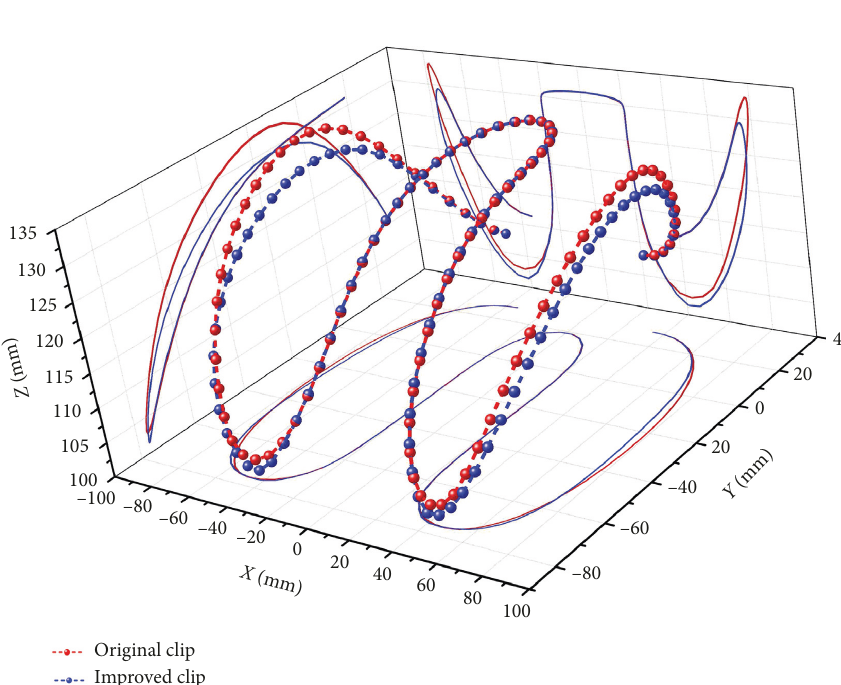
Figure 18: Configuration of the ω -type clip before and after structural improvement.